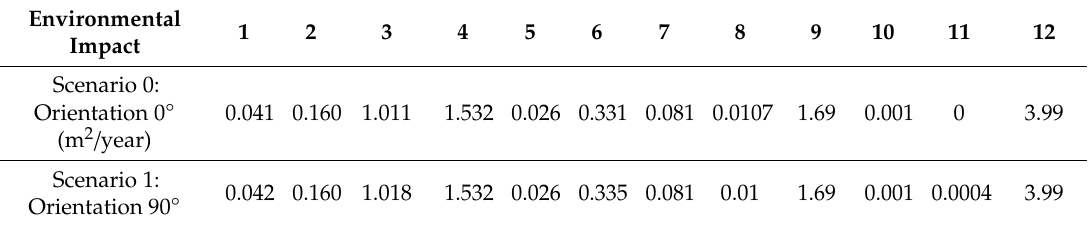
Table 6. Details of orientation scenario per square meter. (1) Greenhouse gas; (2) acidification; (3) cumulative energy demand; (4) waste water; (5) waste products; (6) depletion of abiotic